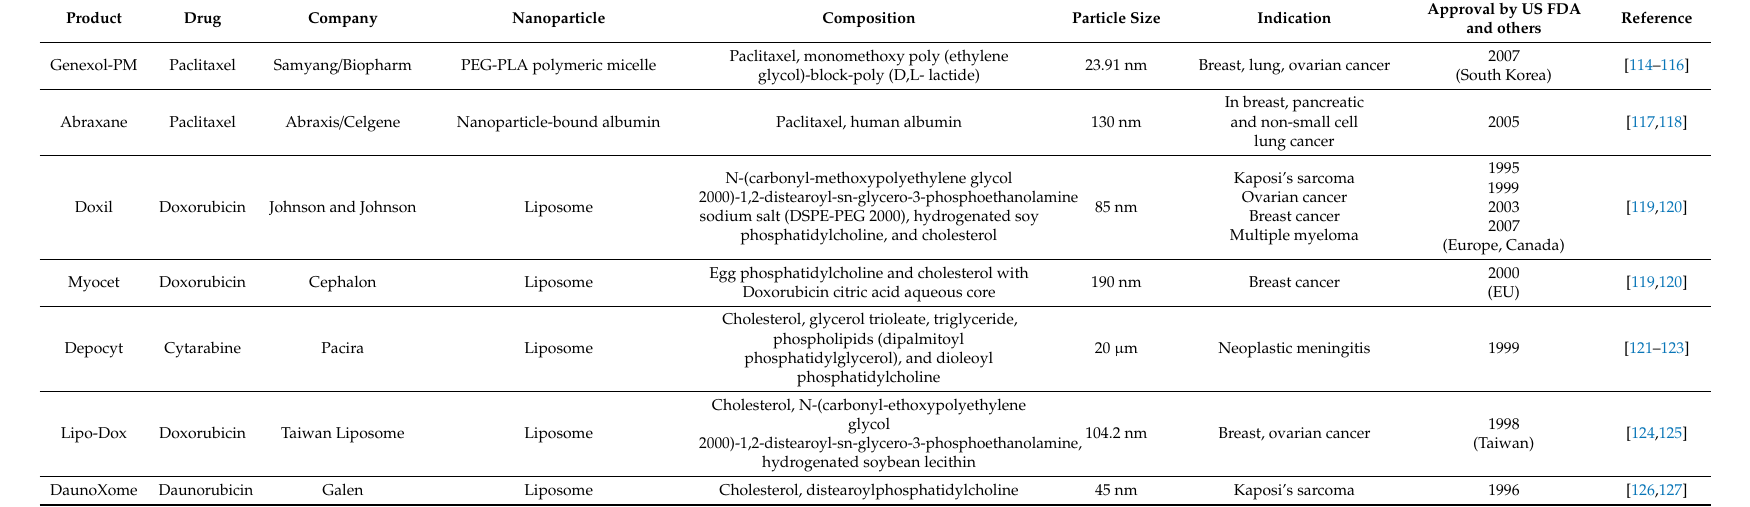
Table 6. List of approved nanotechnology-based cancer drug therapies.